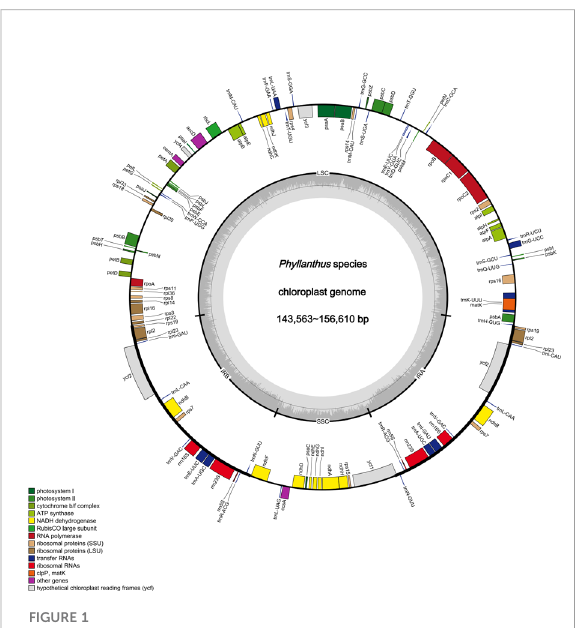
FIGURE 1 Cp genomes map of Phyllanthus . Genes inside and outside the circle are transcribed clockwise and